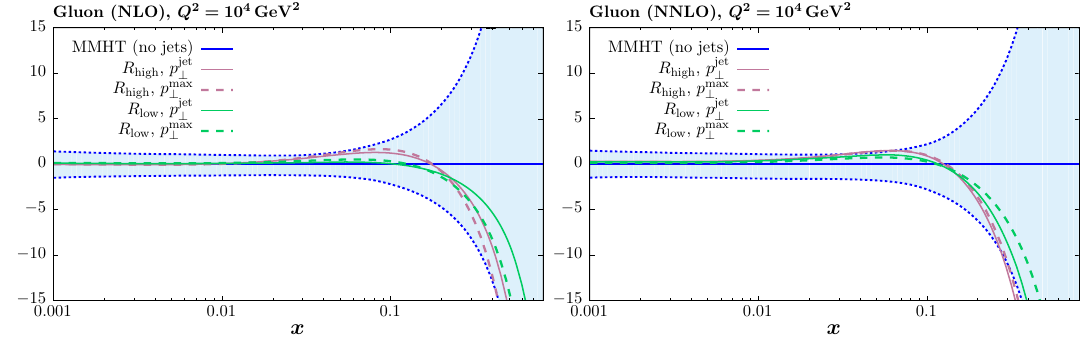
Fig. 7 The impact of the ATLAS [23] and CMS [24] 7 TeV jet data on the gluon PDF at NLO (left) and NNLO (right). The percentage dif- ference in comparison to the baseline fit, with no jet data included, is